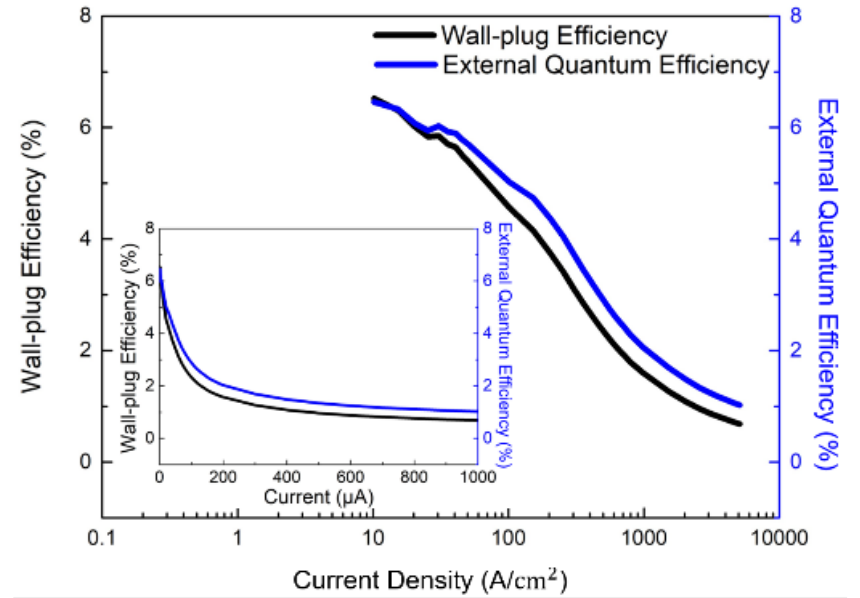
Figure 5. Plot of EQE and WPE as a function of current density in semi-log scale for a single pixel of the 1920×1080 blue InGaN MicroLEDs. Inset: Plot of EQE and WPE versus logarithmic current for a single pixel.